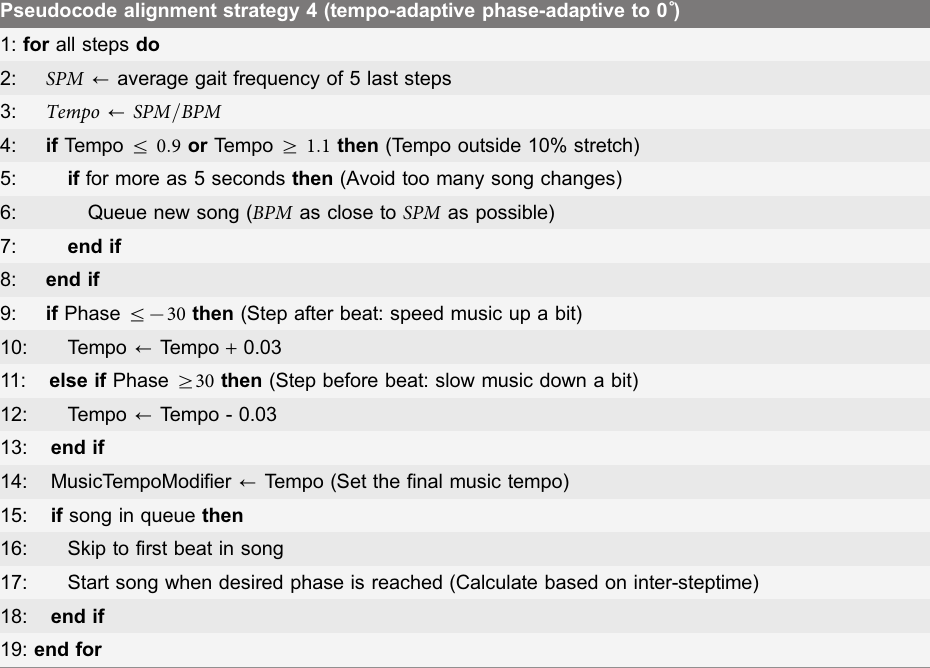
Table 5. Algorithm